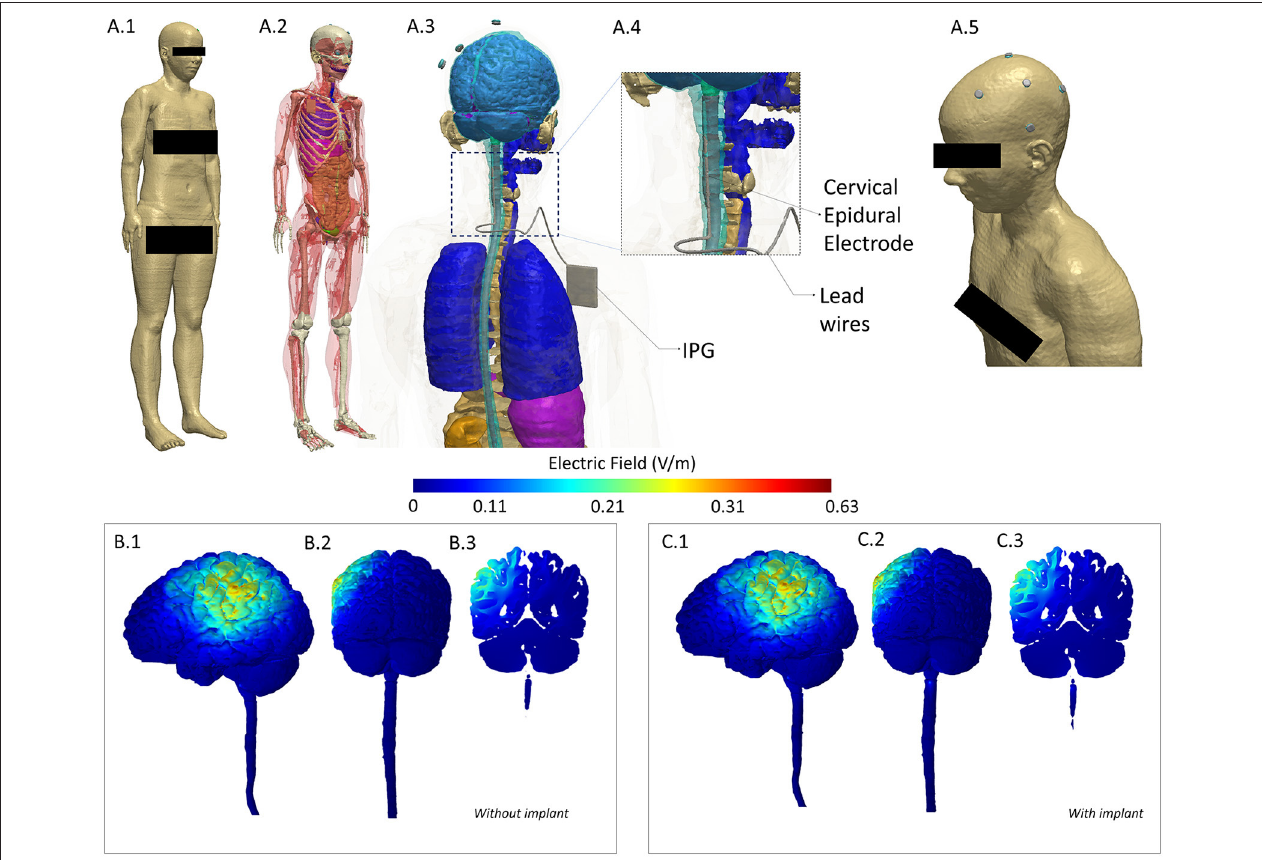
FIGURE 1 | Computational Model of induced electric field to evaluate any alteration due to implant. To investigate deviation (intensity or location of current flow), we considered a model derived from a healthy subject (no implant) and incorporated a spinal cord implant within the same geometry to serve as our implant case. We performed a comparison of induced electric field between the two models and noted a difference of 1.1% in maximum and no difference in mean and median values. (A.1) A full body head model was derived from the Visible Human Project (24). A female dataset was used given the gender of the patient. (A.2) Skin mask is made transparent to reveal tissue segmentation detail. (A.3) Close-up of the model along with geometry of the Spinal Cord Stimulation (SCS) considered. (A.4) The cervical section of the model is expanded to highlight the location of the epidural electrodes and lead wires. (A.5) Skin mask along with stimulation electrodes indicating the montage simulated replicated anodal HD-tDCS over left M1. (B.1–B.3) 3D Left Lateral, 3D Posterior, and 2D coronal plots of induced electric field in the brain and in the spinal cord for the healthy (no implant) situation. (C.1–C3) Corresponding views for the implant situation. Results indicate no alteration in current flow—at left M1 (both at cortical surface and in deeper areas) and in overall pattern. Further, posterior plots indicate no deviation locally at the implant level (see the spinal cord section in B.2,C.2 ). All methods and analyses were based on prior work by our group (25–27). A current injection of 1.5mA and the classic Laplace’s equation was used to determine induced current